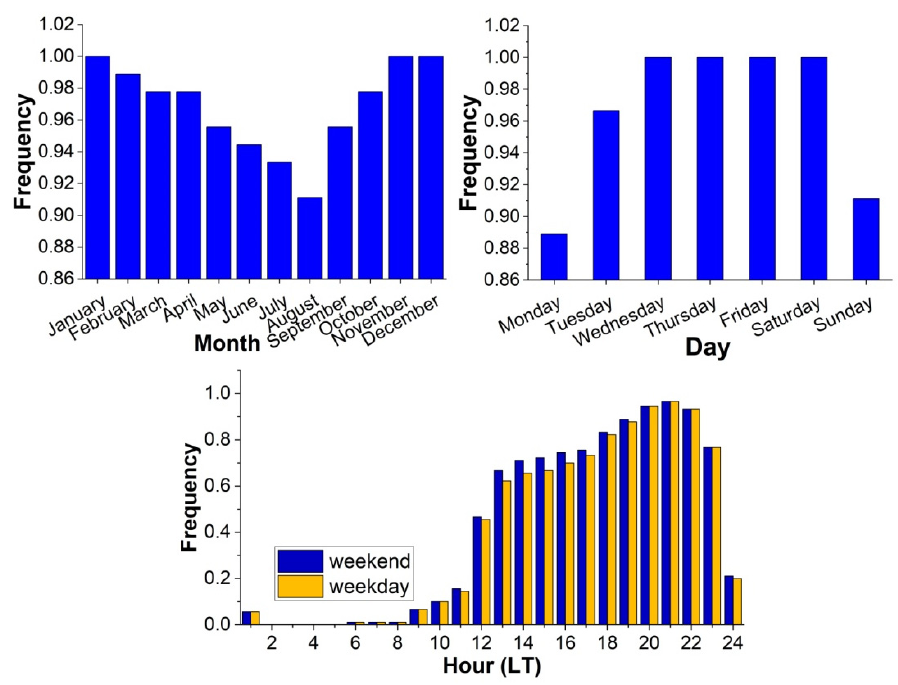
Figure 4. The monthly, daily and hourly profiles of the restaurants’ operation. Table 6. Daily coefficients representing the operation of restaurants in Attica. Table 5. Monthly coefficients representing the operation of restaurants in Attica.